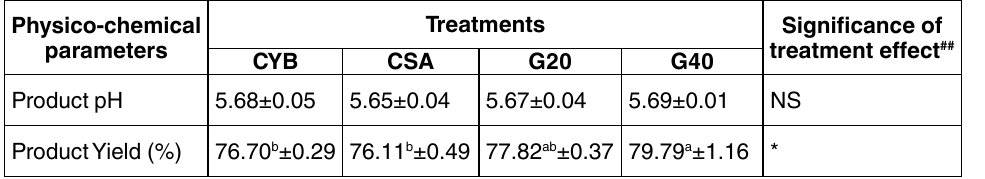
Table 2. Effect of ginger extract marination of spent Japanese quail meat on the